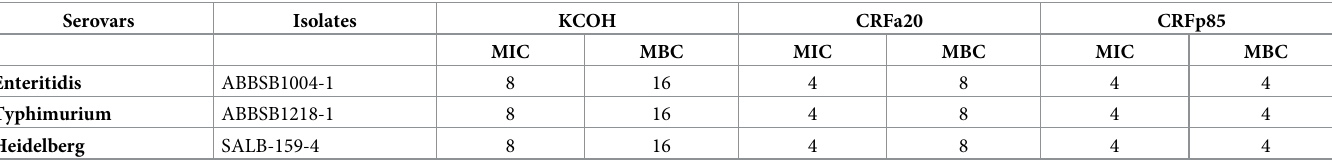
Table 2. Minimal inhibitory concentrations (MICs: mg/ml) and minimal bactericidal concentrations (MBCs: mg/ml) of cranberry pomace extracts (KCOH) and its sub-fractions CRFa20 (anthocyanins) and CRFa85 (polyphenols) against different serovars of Salmonella . Serovars